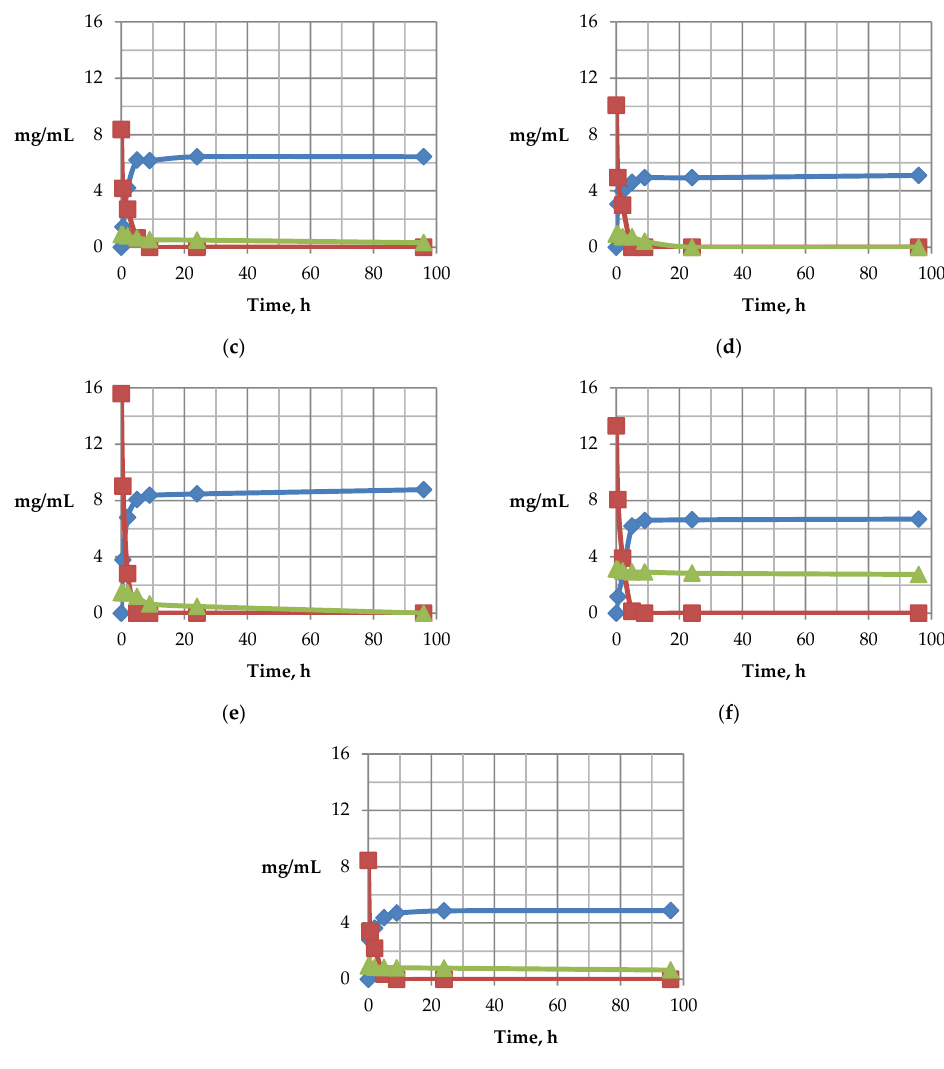
Figure 11. Courses of bioethanol fermentation presenting bioethanol yield (blue) and consumption of glucose (red) and xylose (green) in function of time from following substrates: ( a ) pure glucose; ( b ) AcH; ( c ) AlAcH; ( d ) EH; ( e ) AlEH; ( f ) AcHD; and ( g ) AlAcHD.